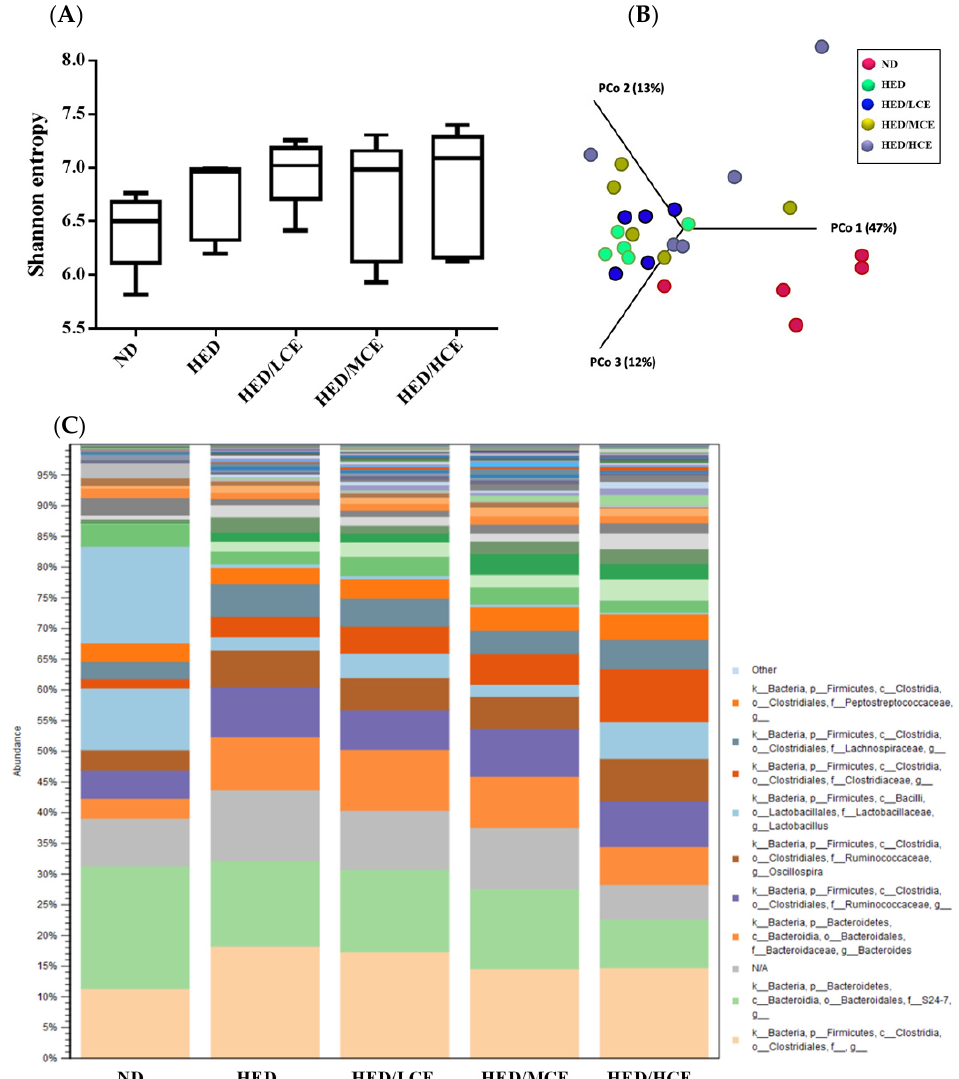
Figure 6 . Effect of phlorotannin-rich extracts from A. nodosum and F. vesiculosus on diversity of gut microbiota in rats with high-energy diet–induced hyperlipidemia. ( A ) Alpha diversity according to Shannon index. ( B ) Beta diversity according to weighted-unifrac principal coordinate analysis plots. ( C ) Relative abundances of